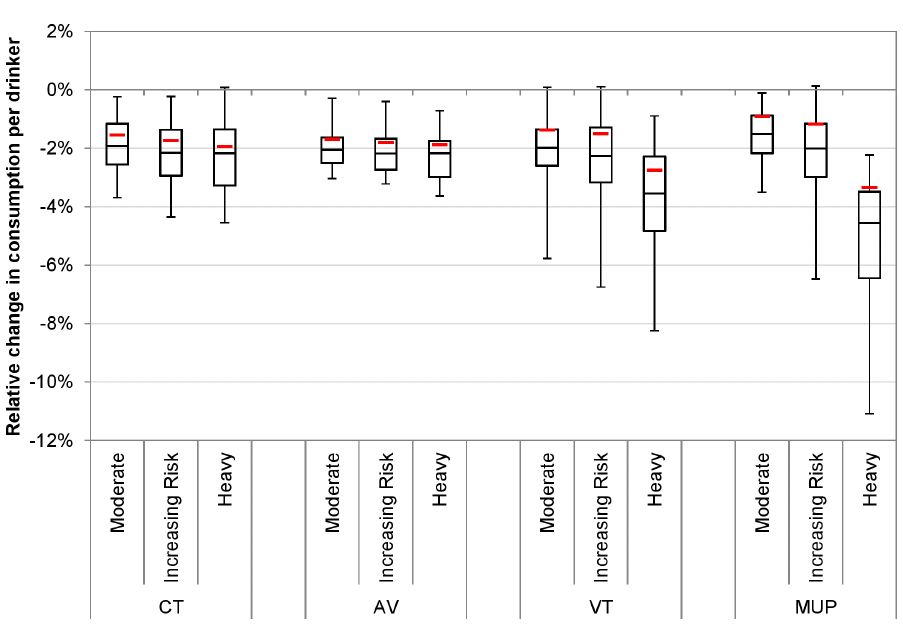
Fig 4. Probabilistic sensitivity analysis results for policy impacts on consumption by drinking level group. This figure shows the uncertainty in estimated policy impacts on alcohol consumption by drinking level group generated from 30 PSA runs. Whiskers represent maximum and minimum values. Boxes represent interquartile ranges. Mid-box lines represent medians. Red lines represent the baseline (deterministic) results. AV, ad valorem tax; CT, current tax increase; MUP, minimum unit pricing; VT, volumetric